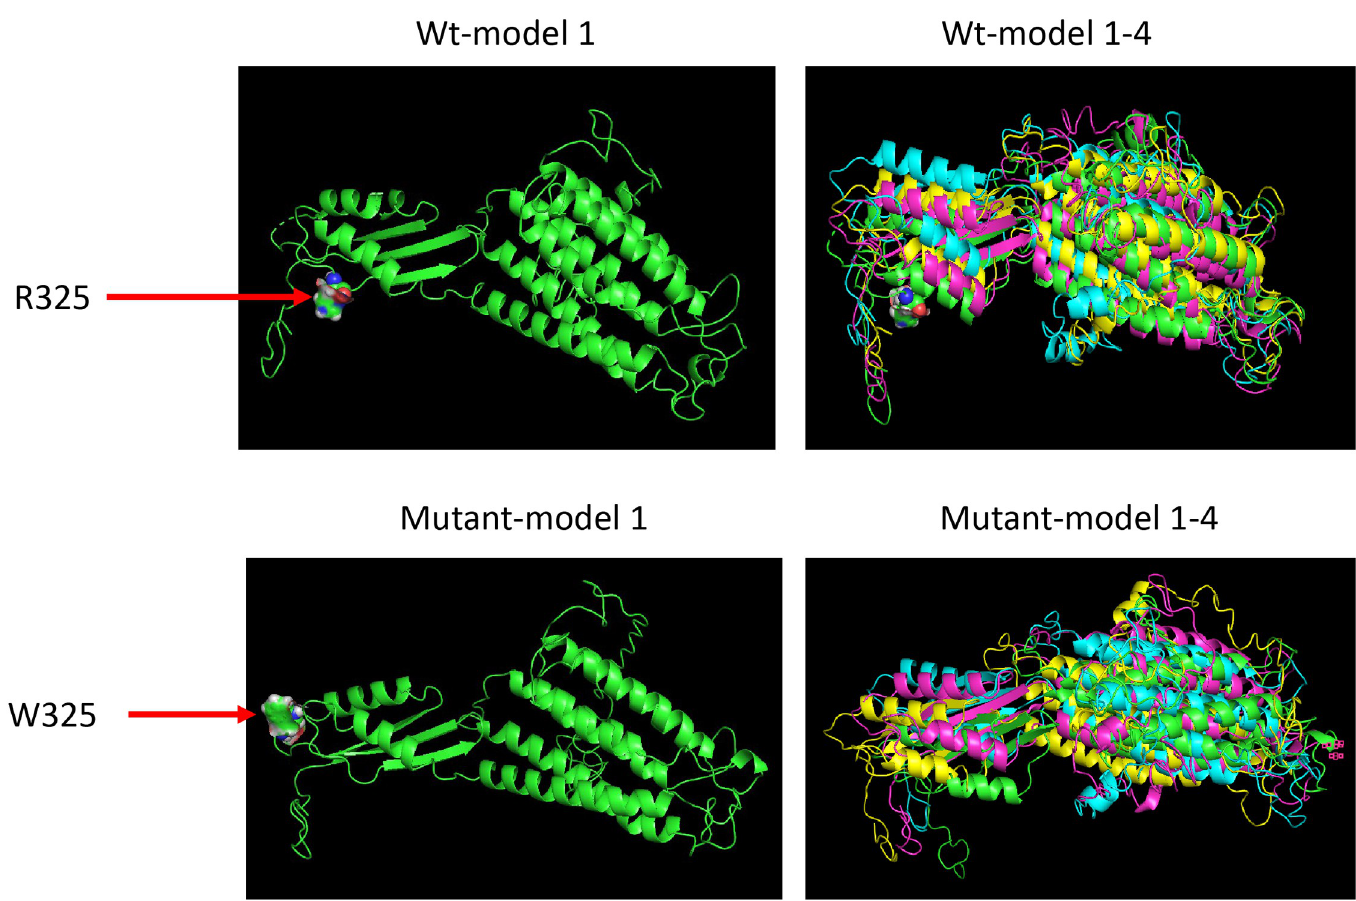
Fig 3. The SLC30A8 protein structures for Wild Type (Wt, top) and R325W (rs1326634, bottom). Each amino acid sequence yielded four predicted protein structures called models 1 to 4 for Wt and mutant, respectively. Wt-Model 1 (top left) is the 1 st 3D structure predicted by comparative molecular modeling through I-TASSER. Wt- Model 1–4 shows the overlap of the four predicted 3D structures for SLC30A8 wild type (top right). The mutant structures (bottom) are labeled